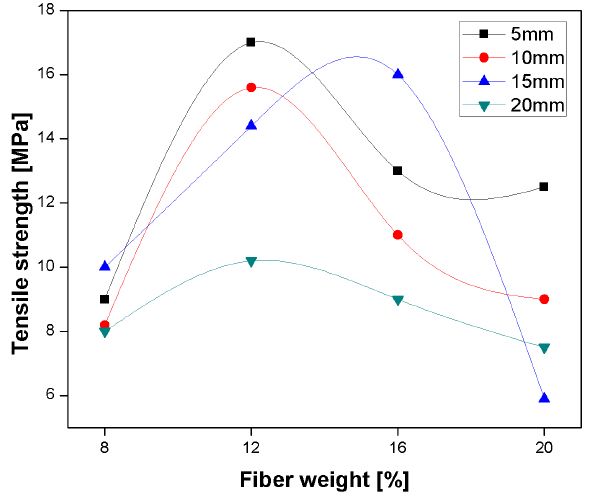
Figure 20. Tensile strength of chopped fibre (5 mm) length at different fibre loading (8, 12, 16, and 20 wt. %) of banana/epoxy composite.